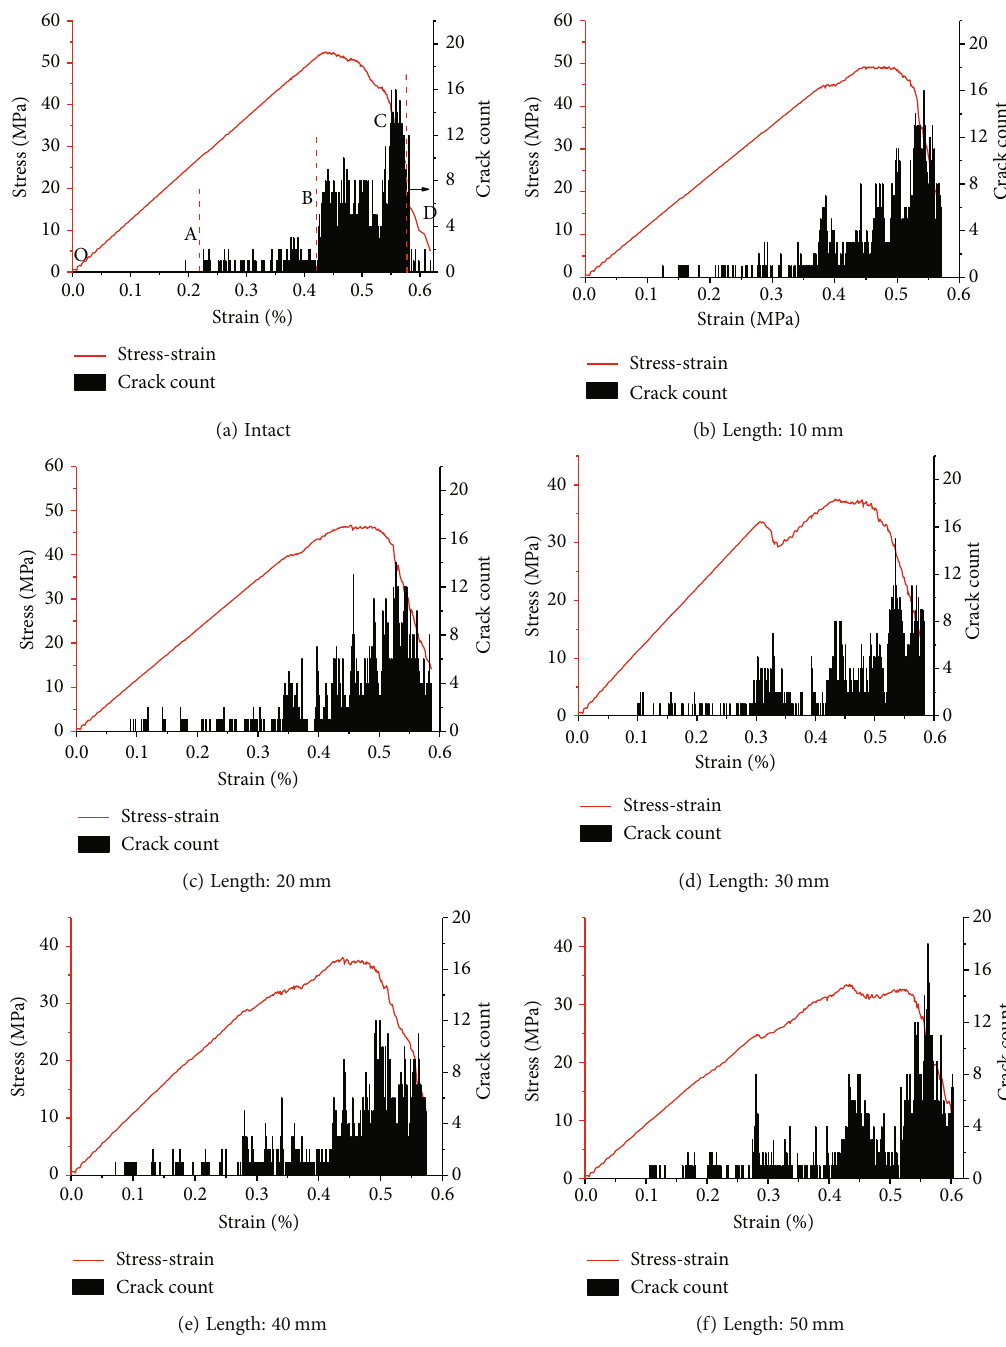
Figure 8: Stress-crack count curve of models with di ff erent joint